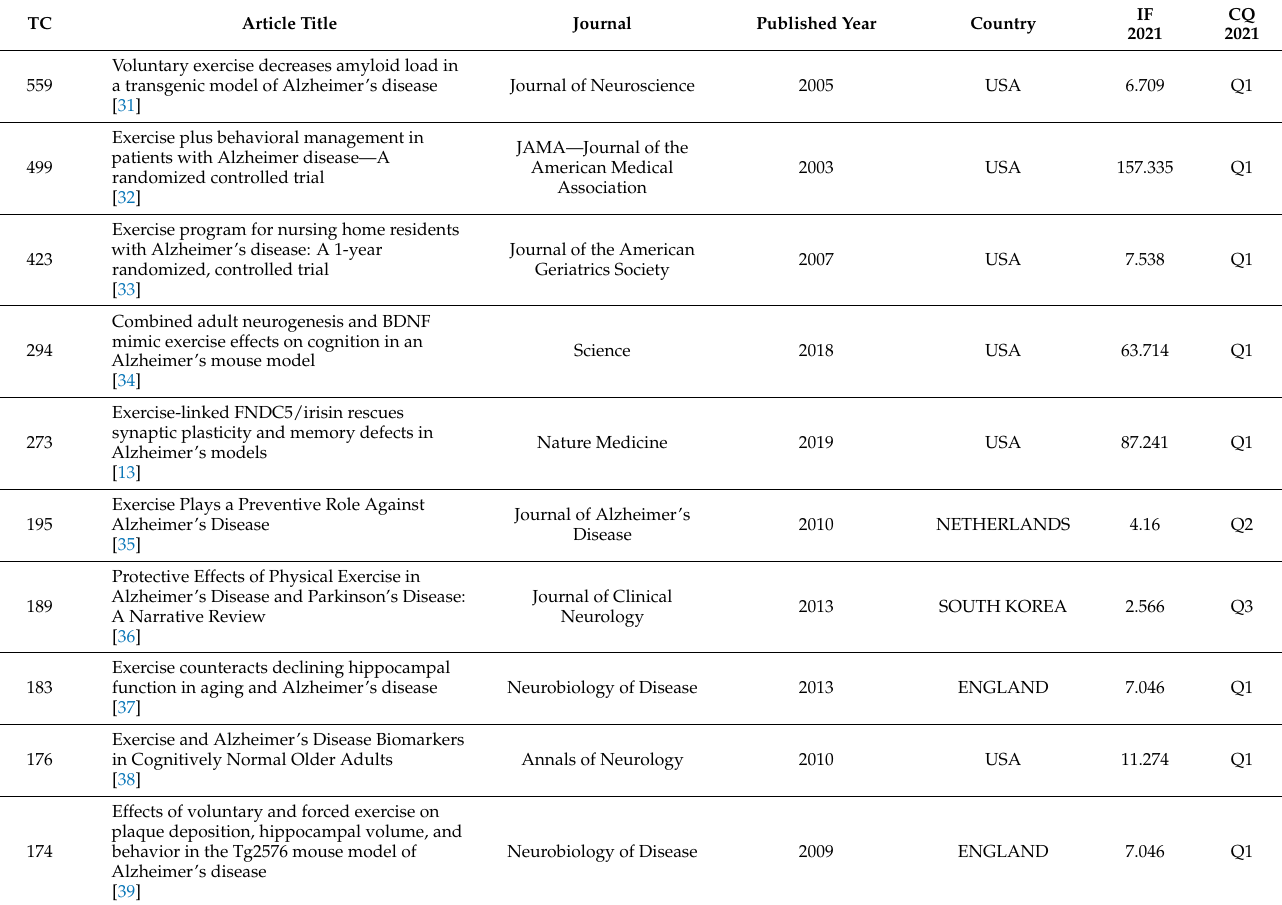
Table 2. Characteristics of the top 10 most highly cited documents on AD exercise research.